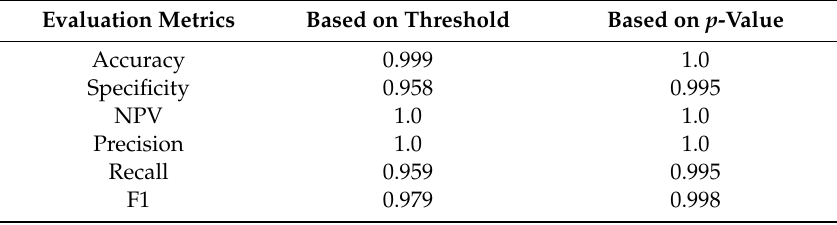
Table 6. Performance result based on